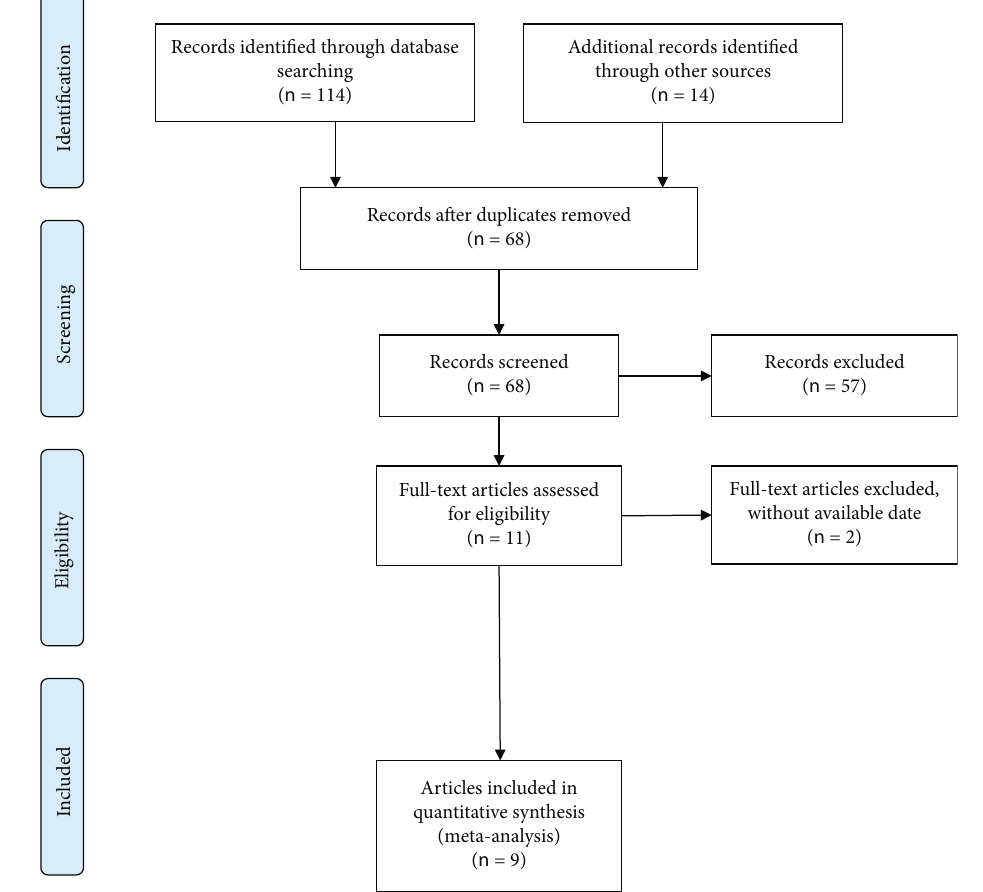
Figure 1: The literature screening